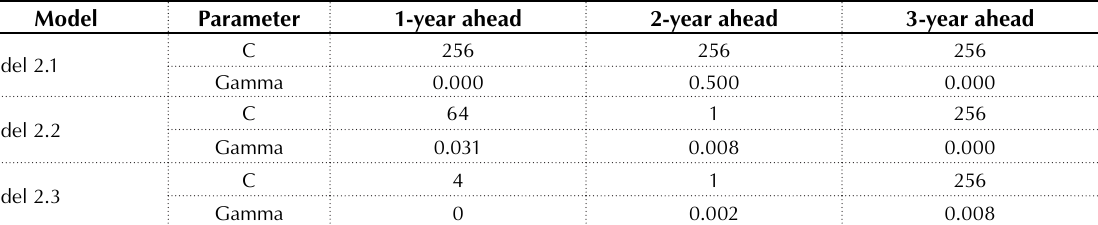
Table A7. Summary of C and